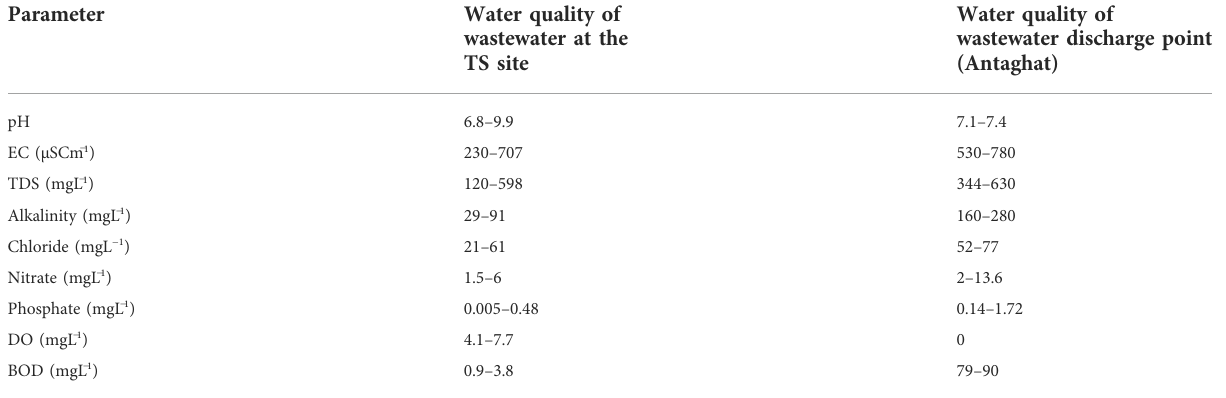
TABLE 3 Average values of selected parameters analyzed at the time series site and wastewater discharge point